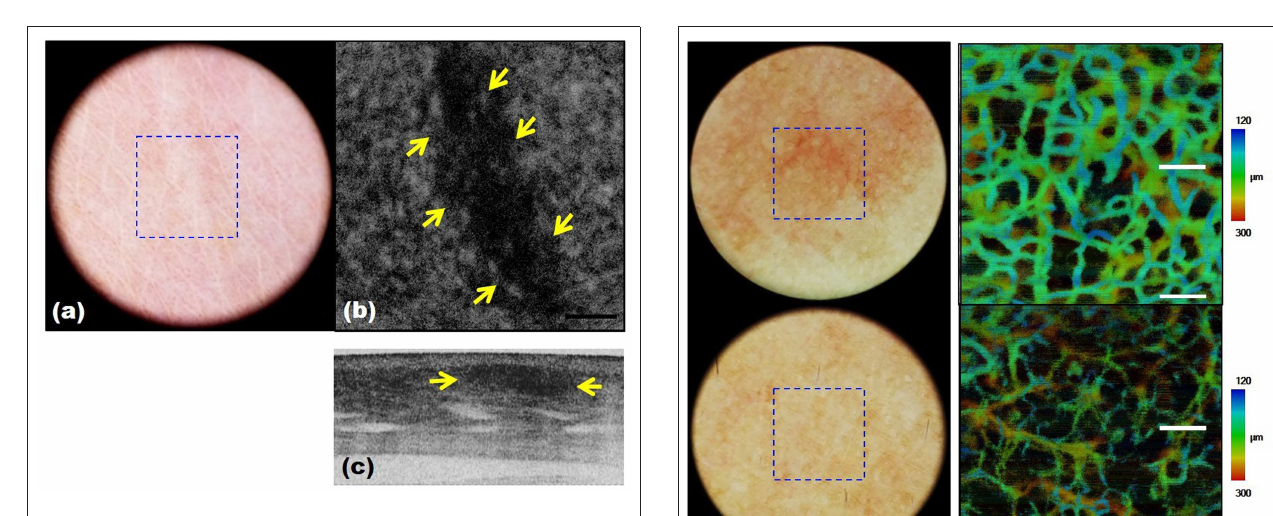
FIGURE 8 | Scar images by dermoscopy-guided multifunctional optical coherence tomography (OCT). (a) Dermoscopic image. (b,c) Intensity OCT showing a dark area and frequent banding pattern due to stronger light scattering and birefringence.